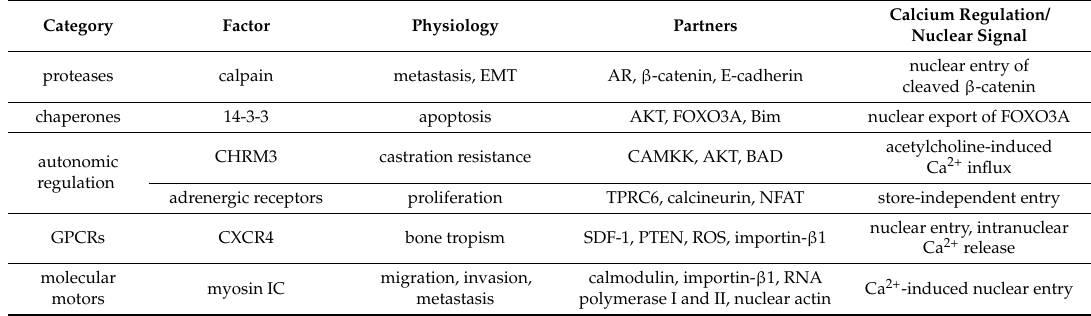
Table 3. Additional molecular classes involved in the calcium and nuclear signaling in prostate